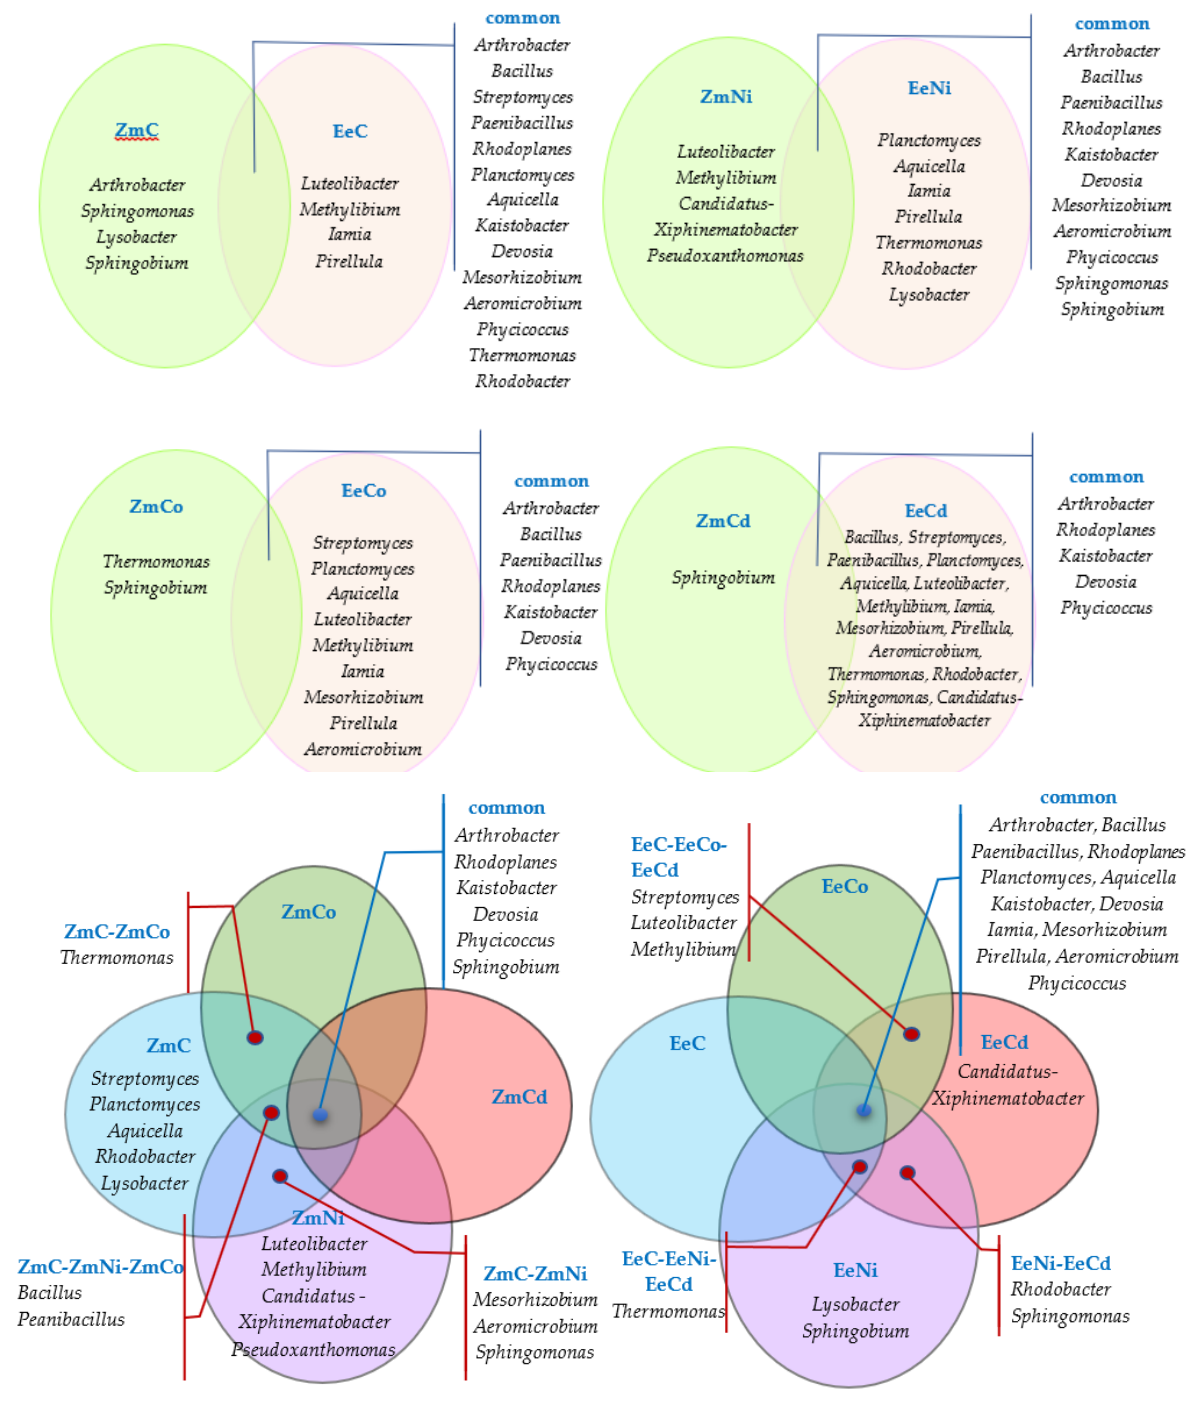
Figure 9. Unique and common bacterial genera in the soil polluted with heavy metals (Venn diagram). Ee— Elymus elongatus L.; Zm— Zea mays L.; Org—organotrophic bacteria; Act—actinobacteria; Fun—fungi. C—control soil; Ni—soil contaminated with Ni 2+ ; Co—soil contaminated with Co 2+ . Cd—soil contaminated with Cd 2+ .